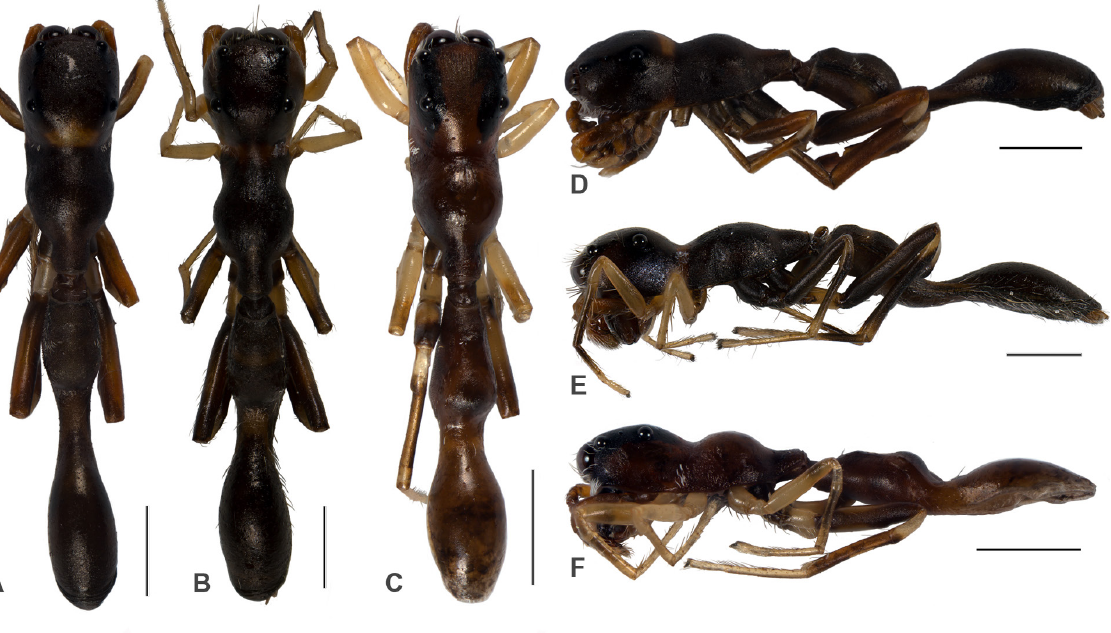
Fig. 3. Dorsal and lateral habitus, males (all CBF). A , D . Synemosyna aurantiaca (Mello-Leitão, 1917). B , E . S. myrmeciaeformis (Taczanowski, 1871). C , F . S. nicaraguaensis Cutler, 1993. Scale bars = 1